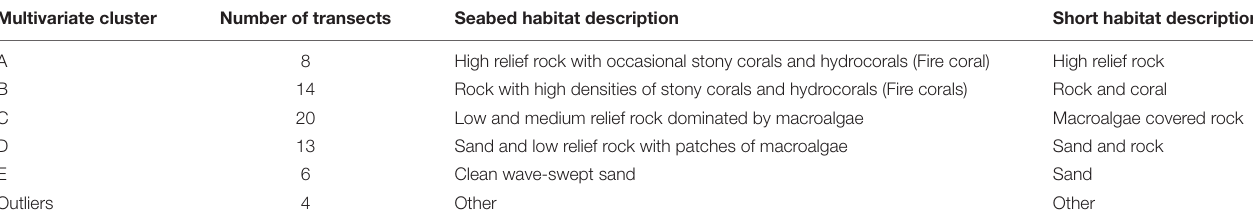
TABLE 2 | Results of the multivariate clustering with the number of transects for each cluster and a habitat description based on the substrate and characterizing taxa. Multivariate